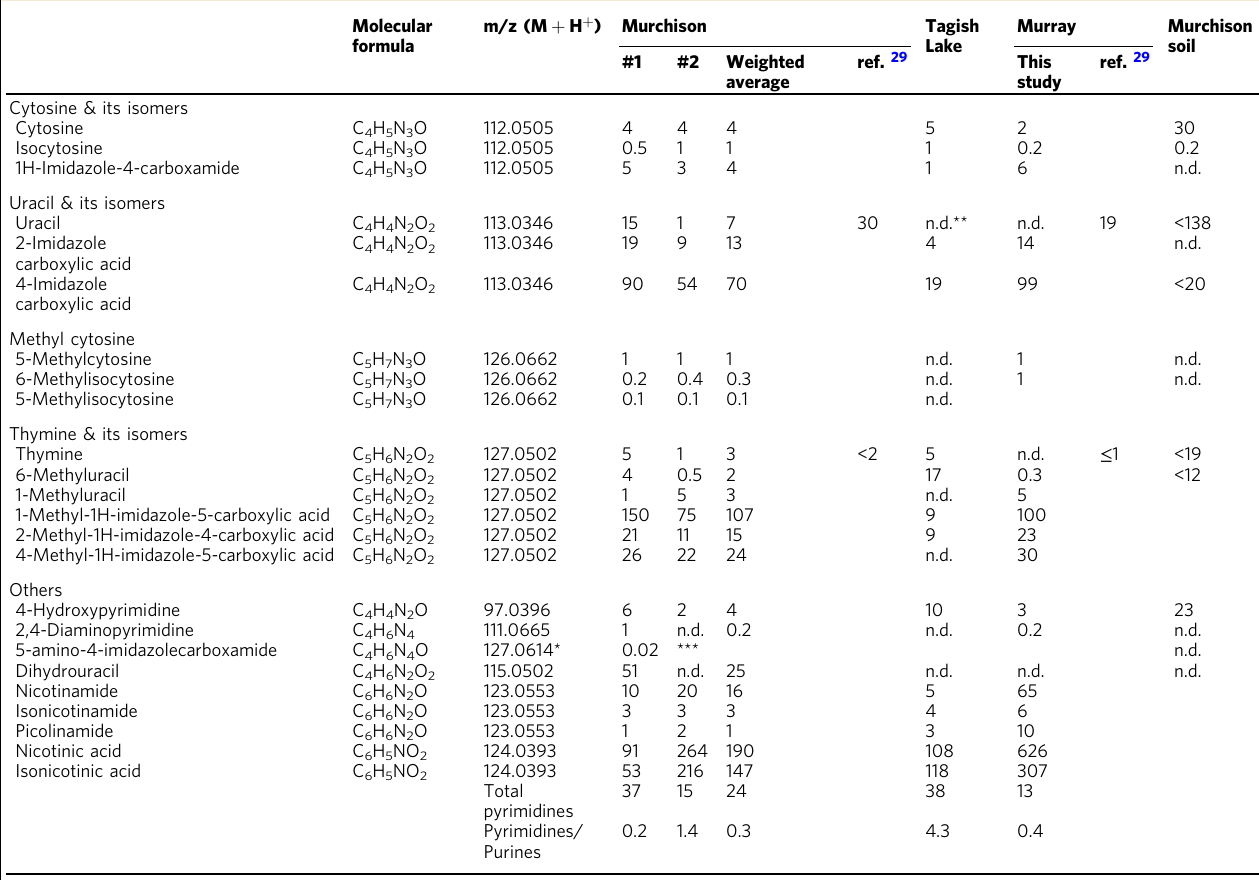
Table 2 Variations in the concentration (in ppb) of pyrimidine nucleobases and their related analogs in meteorite extracts and the Murchison